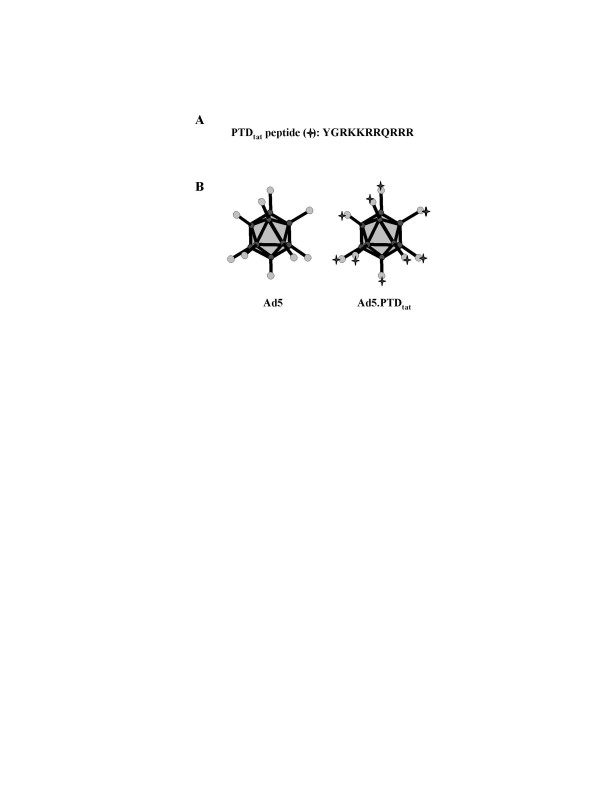
Diagram of PTDtat modified Ad5 vector. (A) PTDtat peptide incorporated into the fiber knob domain. (B) Structural diagram of Ad5 and Ad5.PTDtat vector. The PTDtat motif was incorporated at the C-terminal end of the fiber.